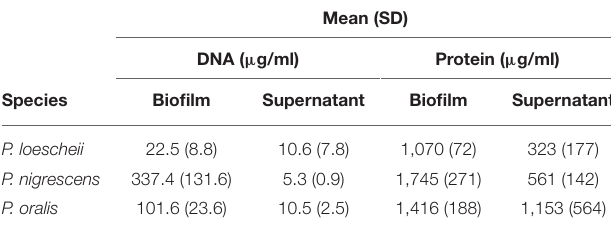
TABLE 1 | Biochemical characterization of the Prevotella